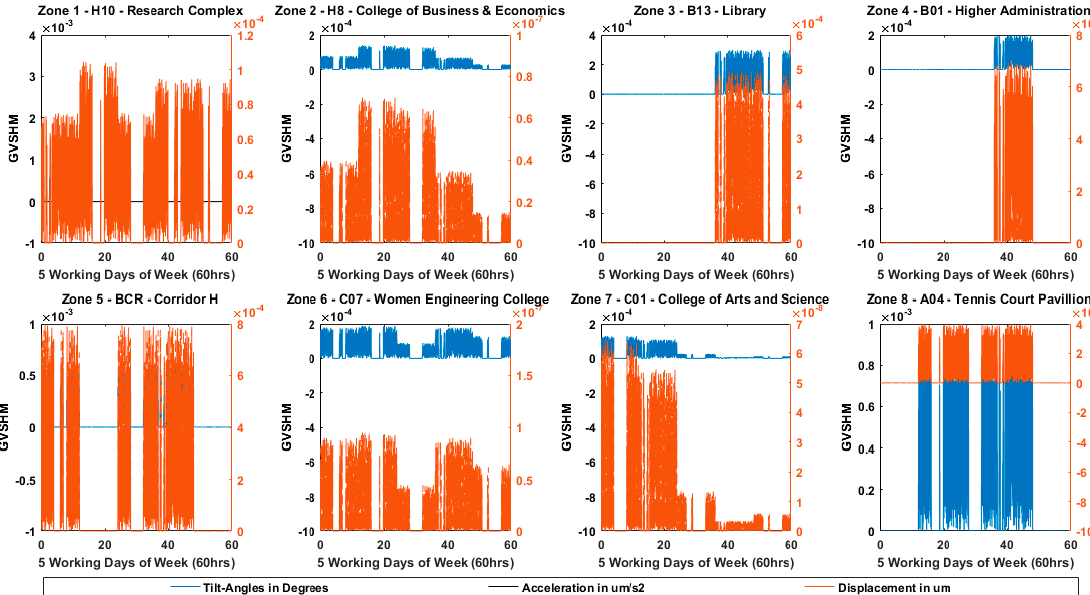
Figure 14. MOSPA predicted SHM Safety Zones for GAN.